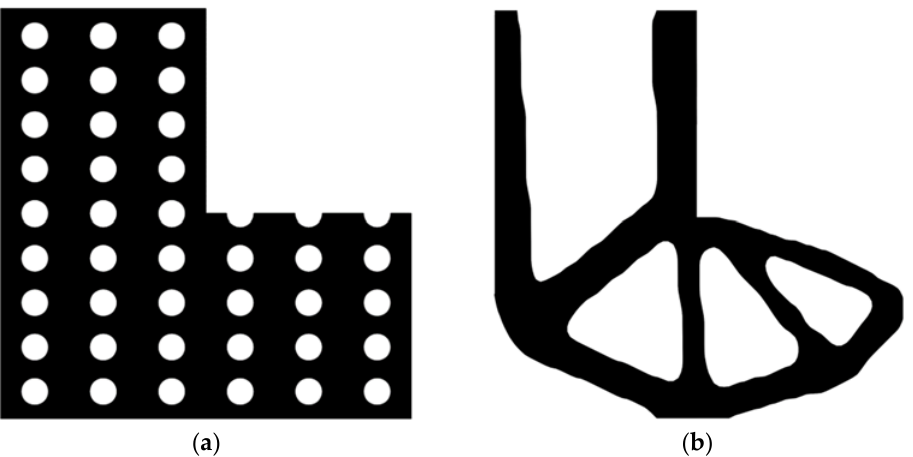
Figure 27. Optimal design problem of L-shaped beam by classical level set topology optimization, ( a ) initial shape; ( b ) optimized shape.